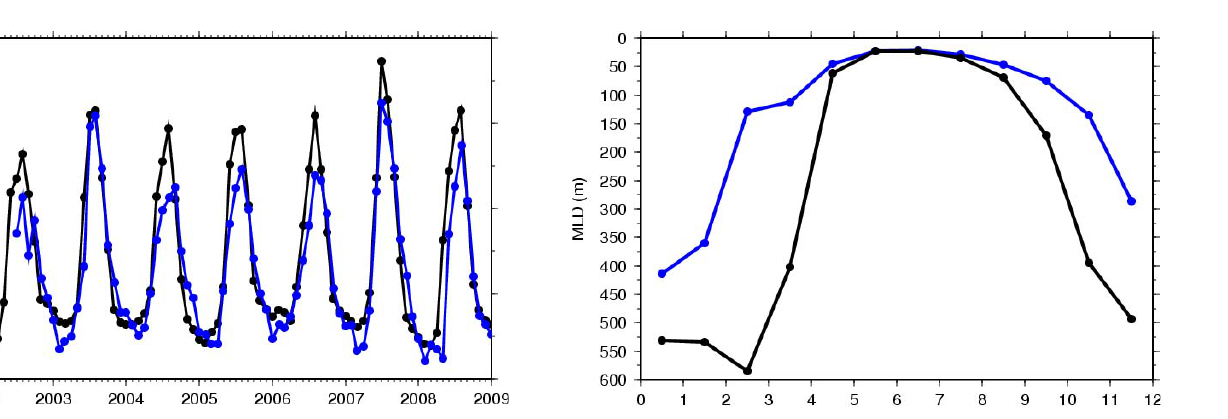
Fig. A1. Time series of monthly GPOMZ (black) and MODIS (blue) SST at the location of ECO1D-2.0 simulation (60 ◦ N, 30 ◦ W). GPOMZ temperature profiles were bias-corrected based on monthly WOA05 climatologic profiles. GPOMZ SST is 0.78 ◦ C warmer on average (1981-2008) when compared to WOA05 SST climatology. The adjusted GPOMZ SST has a 0.31 ◦ C warm bias when compared to MODIS SST (July 2002 – December 2008), as shown in this figure.